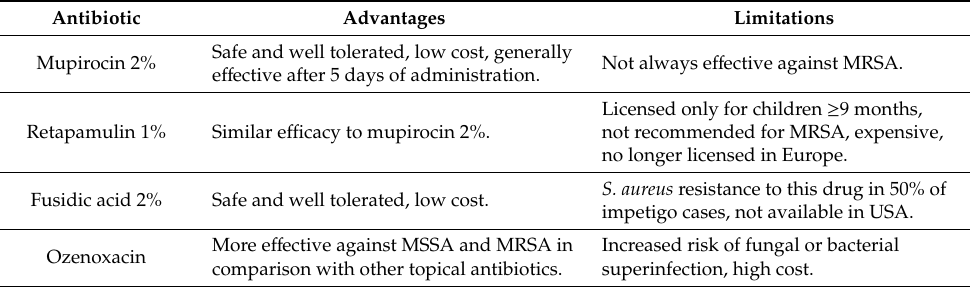
Table 1. Topical antibiotics for the treatment of